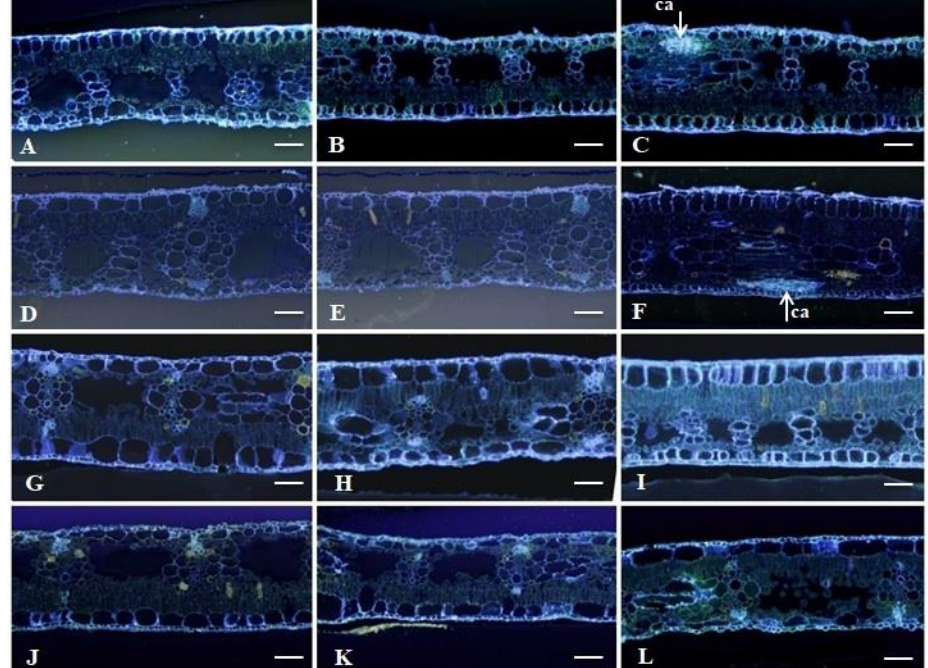
Figure 7. Cross sections of banana leaves of the genotypes Calcutta 4 ( A – C ), Krasan Saichon ( D – F ), Grand Naine ( G – I ), Akondro Mainty ( J – L ) inoculated with P. fijiensis . ( A , D , G , J ) = uninoculated plants. The images are for 0, 9 and 21 DAI, respectively. Histochemical test with aniline blue for callose detection. ca: callose deposition; bar: 200 µ m. Cruz das Almas-BA,